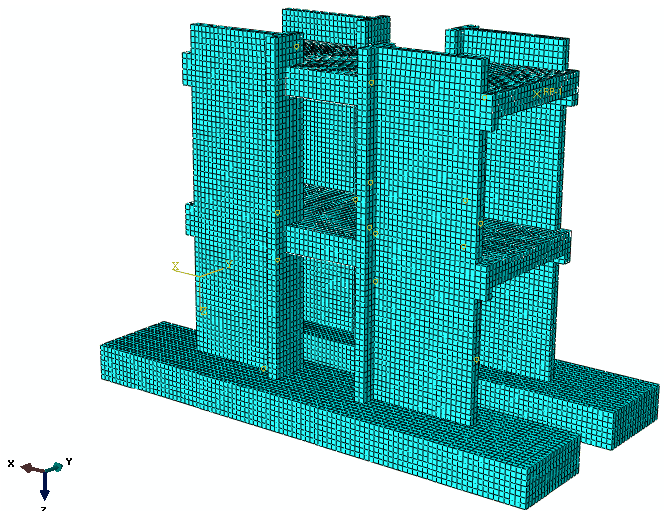
Figure 7. Finite element model meshing.